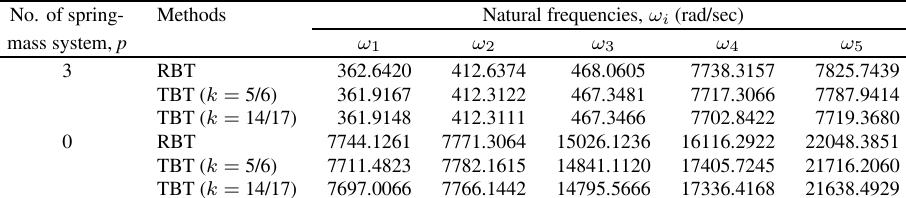
Table 5 The fi rst fi ve natural frequencies of the uniform four-span Reddy-Bickford and Timoshenko beams